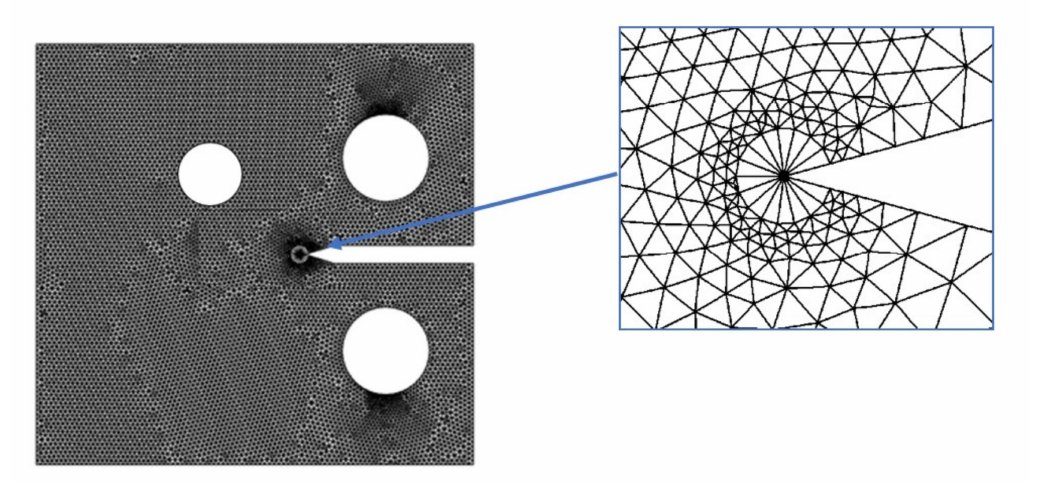
Figure 5. Finite element mesh for the modified compact tension